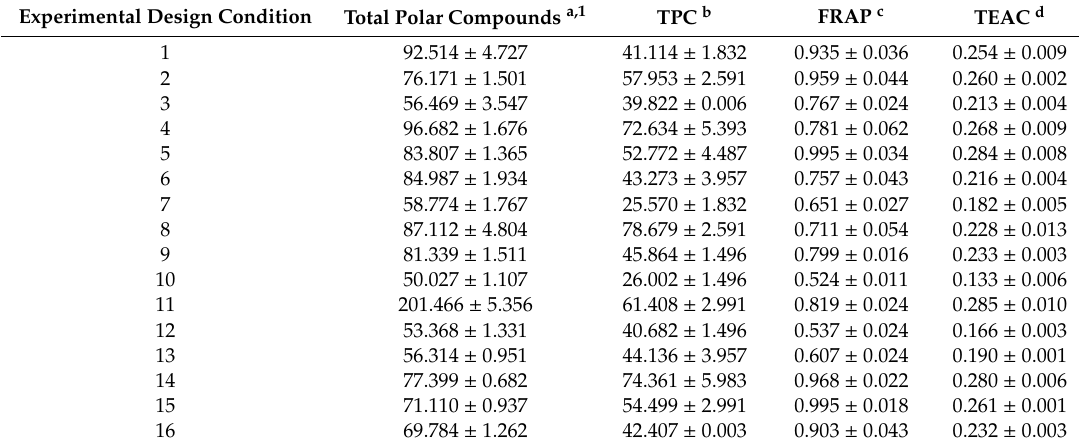
Table 1. Results of the response variables Total Polar Compounds, TPC, FRAP and TEAC for each condition in H. sabdari ff a MAE extracts.